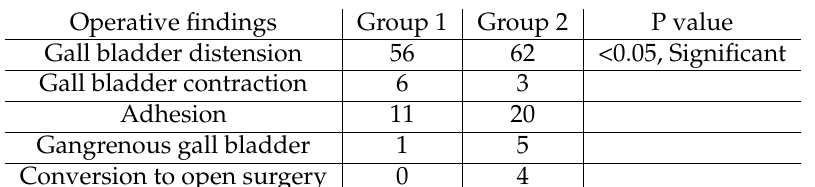
Table 3. Operative